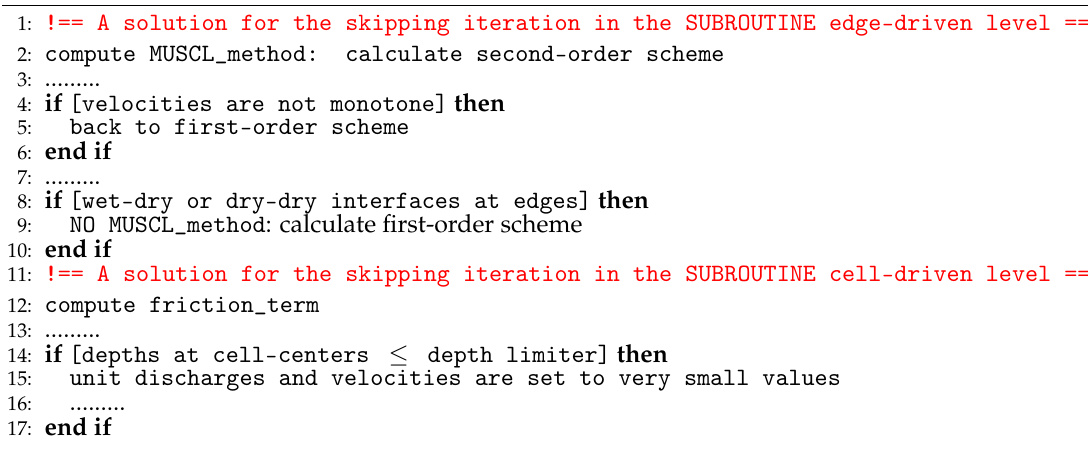
Algorithm 6 Pseudo-code of the solutions of the skipping iterations in Algorithm